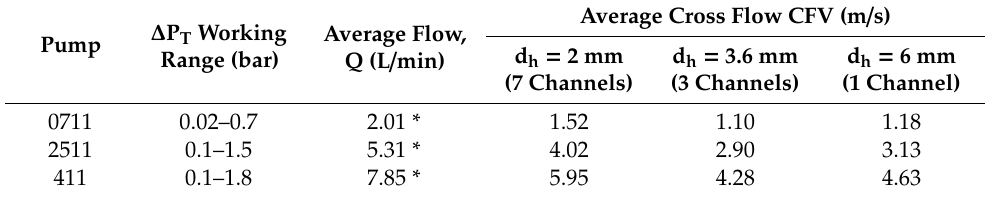
Table 1. Flow and crossflow velocity (CFV) for each pump and hydraulic diameter.